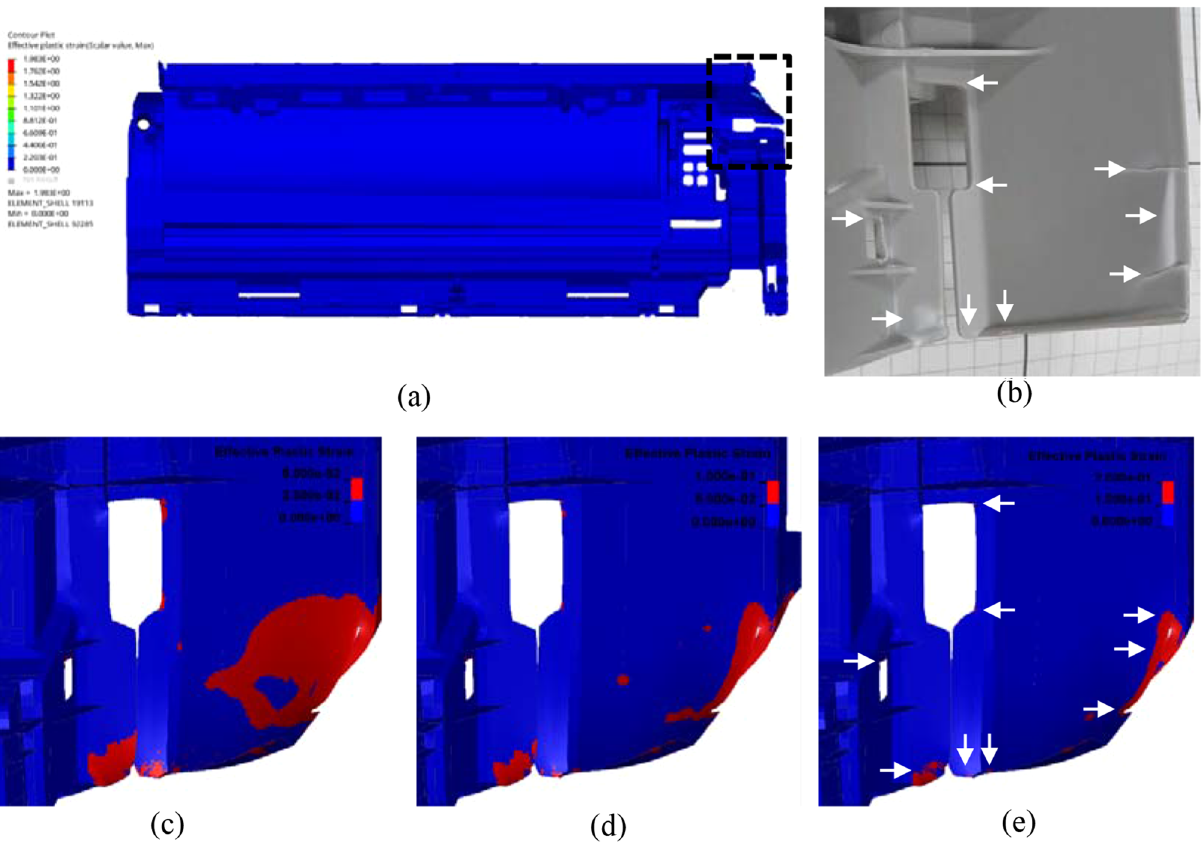
Figure 14. View of ( a ) base plate (closely observed area is shown inside rectangular), ( b ) whitening regions in real part in comparison to effective plastic strain FE map under crazing criteria of ( c ) 0.025, ( d ) 0.05 and ( e ) 0.1 (red regions: predicted whitening caused by crazing and white arrows: correctly predicted whitening